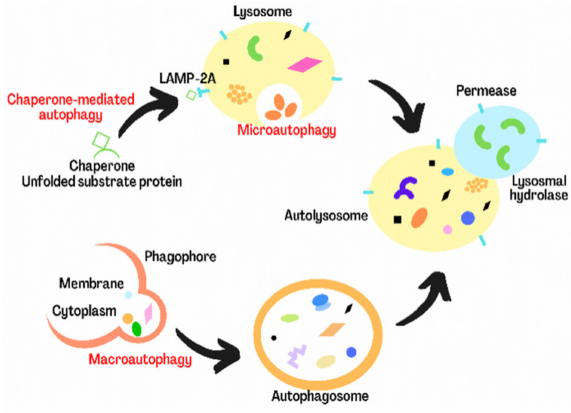
Figure 2. The process of three types of